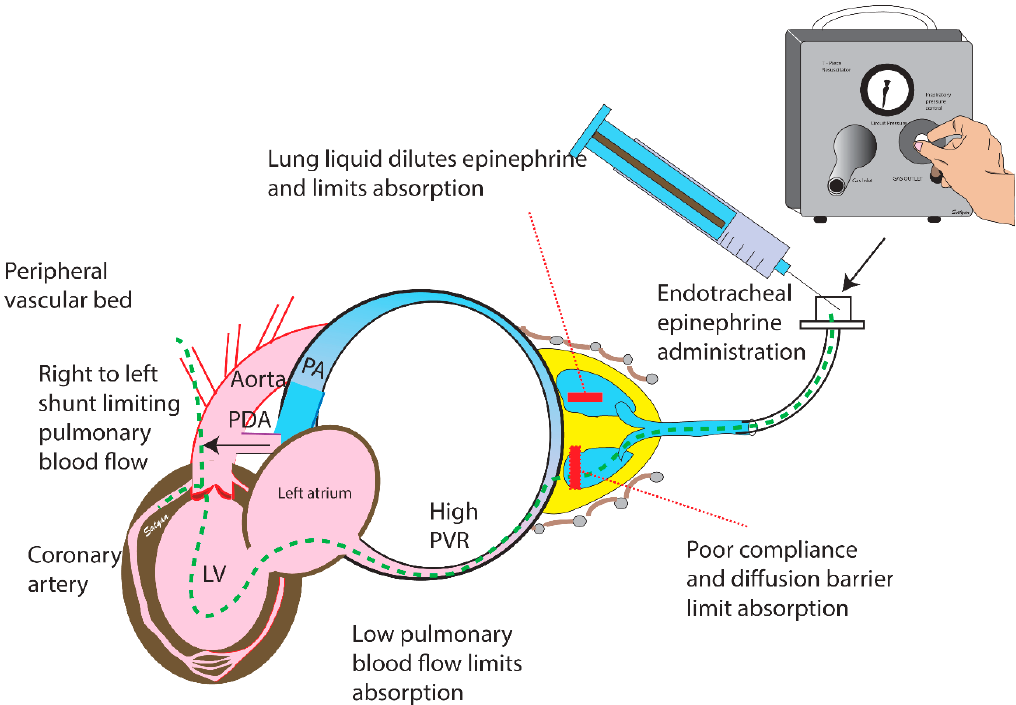
Figure 4. Endotracheal epinephrine. Asphyxia and acidosis decrease systemic vascular resistance by dilating the peripheral vascular bed, and high fetal pulmonary vascular resistance may lead to right to left shunting at the PDA limiting pulmonary blood flow. The presence of fetal lung liquid may dilute tracheal epinephrine, and absorption is further compromised by low pulmonary blood flow. The dashed green line represents the proposed path of intratracheal epinephrine. A higher dose of endotracheal epinephrine may compensate for dilution of lung liquid and overcome the diffusion barrier to achieve higher plasma concentrations. LV: Left ventricle; PA: Pulmonary artery; PDA: Patent ductus arteriosus; PVR: Pulmonary vascular resistance. Copyright Satyan Lakshminrusimha.